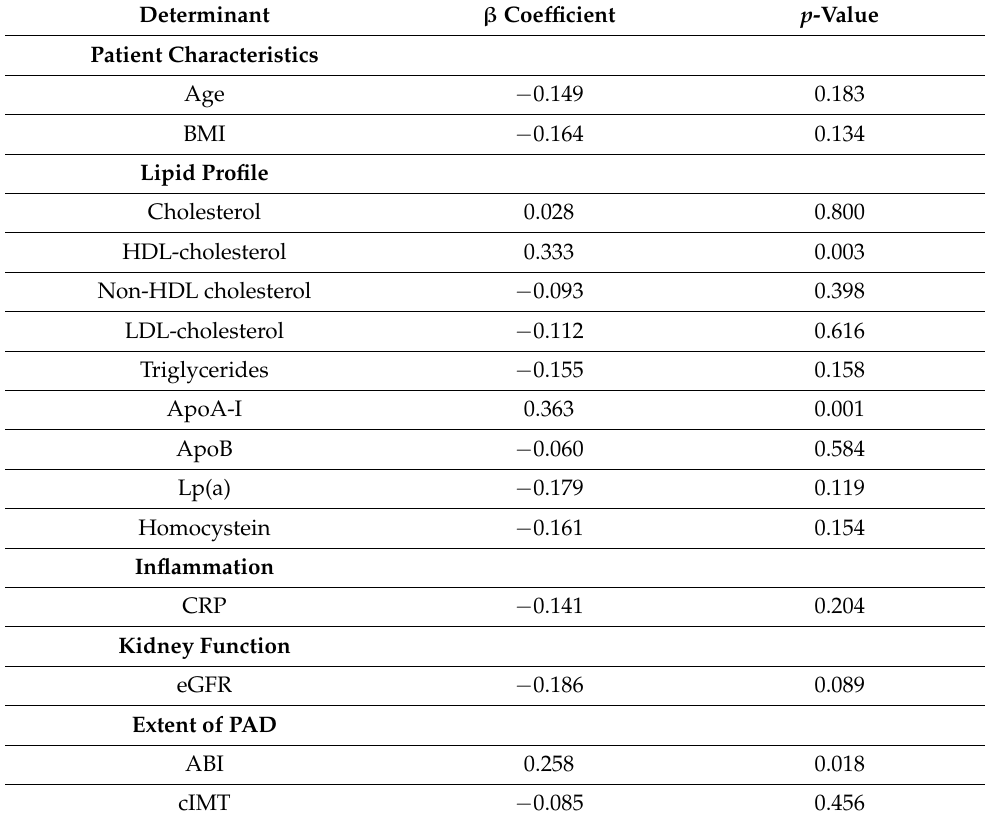
Table 2. Relationship of traditional cardiovascular risk factors with CEC in patients with peripheral artery